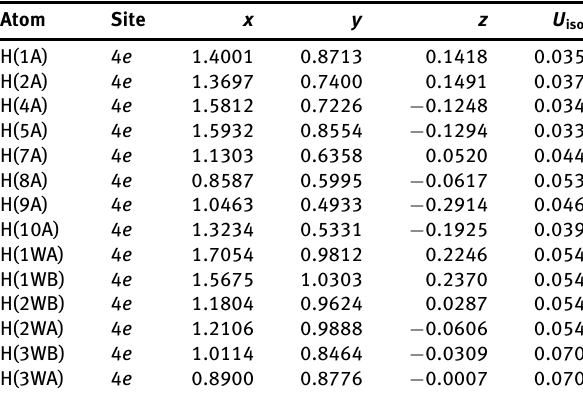
Table 2: Fractional atomic coordinates and isotropic or equivalent isotropic displacement parameters (Å 2